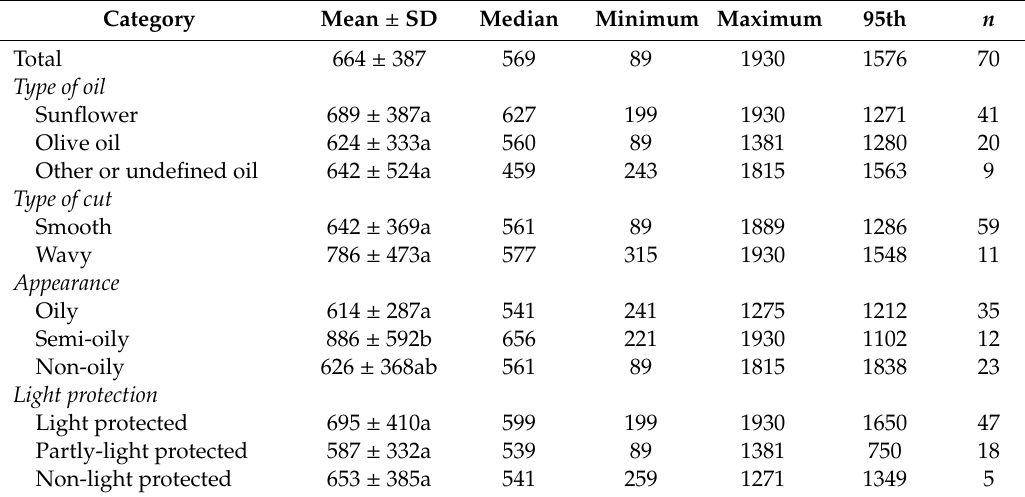
Table 1. Statistical analysis of the acrylamide levels ( µ g / kg) of di ff erent potato crisp